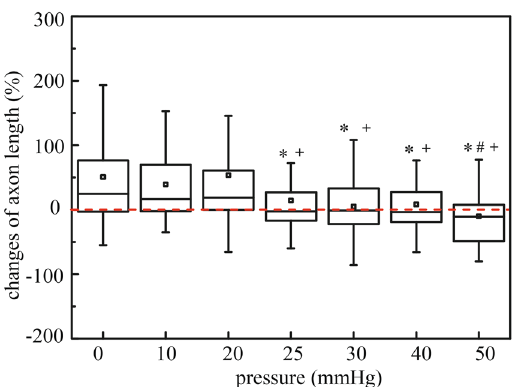
Figure 5. Box plot of axon length after applied hydrostatic pressures of 0 mmHg (n = 155 RGCs), 10 mmHg (n = 67 RGCs), 20 mmHg (n = 109 RGCs), 25 mmHg (n = 77 RGCs), 30 mmHg (n = 76 RGCs), 40 mmHg (n = 80 RGCs), and 50 mmHg (n = 74 RGCs) for 72 hours. Box plot whiskers indicate the maximum and minimum values of the data. The symbols * , # and + indicate statistically different results from 0 mmHg (P < 0.05), 10 mmHg (P < 0.05), and 20 mmHg (P < 0.05) respectively by one-way ANOVA followed by Bonferroni post-hoc